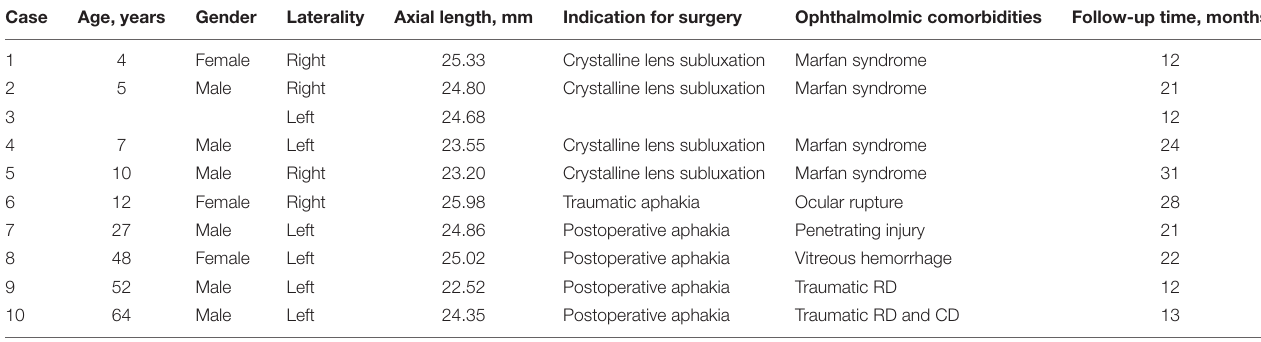
TABLE 1 | Individual patient characteristics.